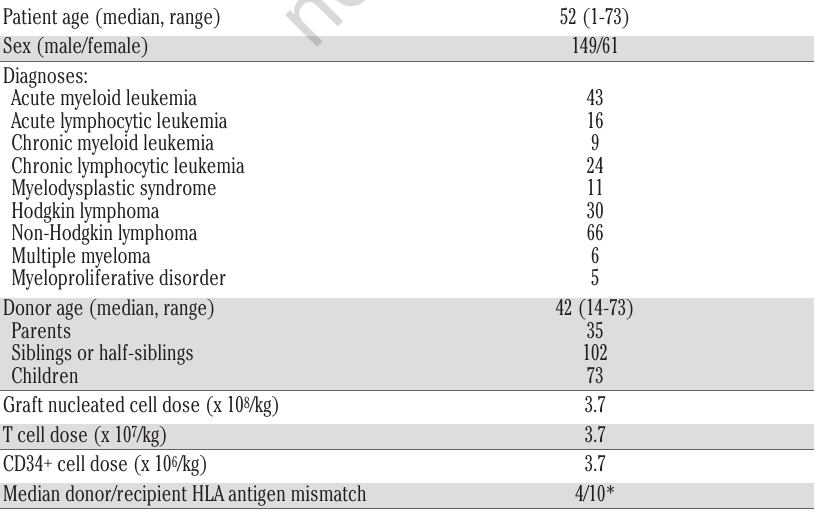
Figure 2. Cumulative incidence of acute (A) and chronic (B) GVHD after nonmyeloablative haploidentical stem cell transplantation with post-transplantation cyclophosphamide. n=210 Table 1. Patient, donor, and graft